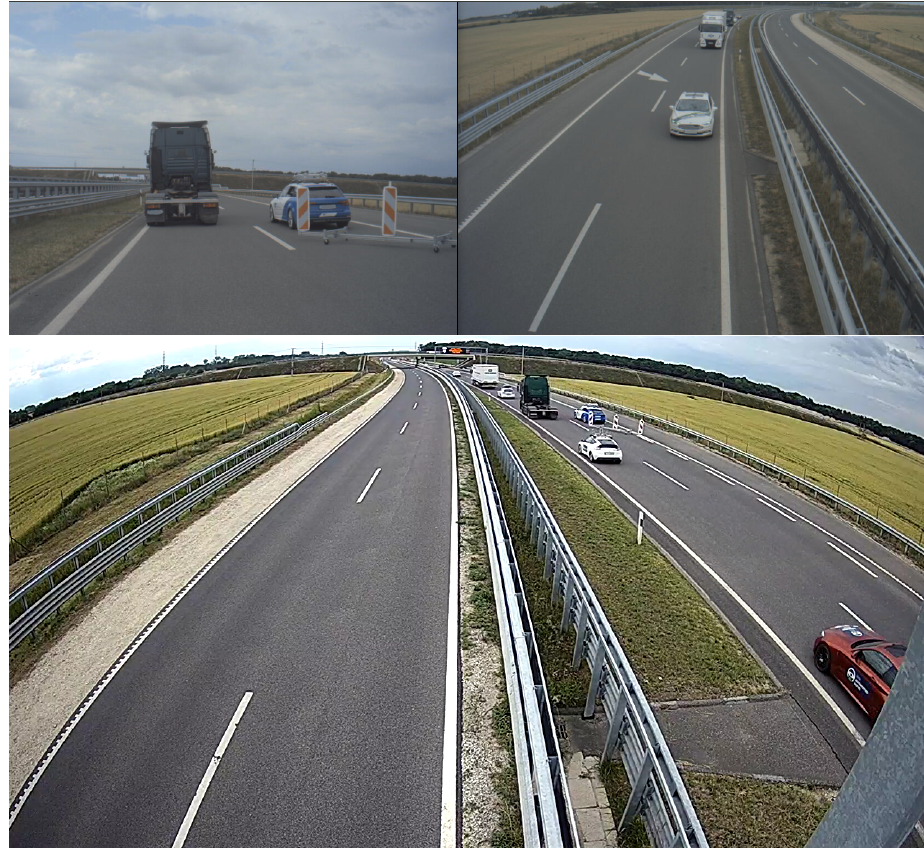
Figure 28. Pictures from the same moment of time from the point of view of the measurement vehicle ( upper left ) and the two infrastructure cameras ( upper right and down